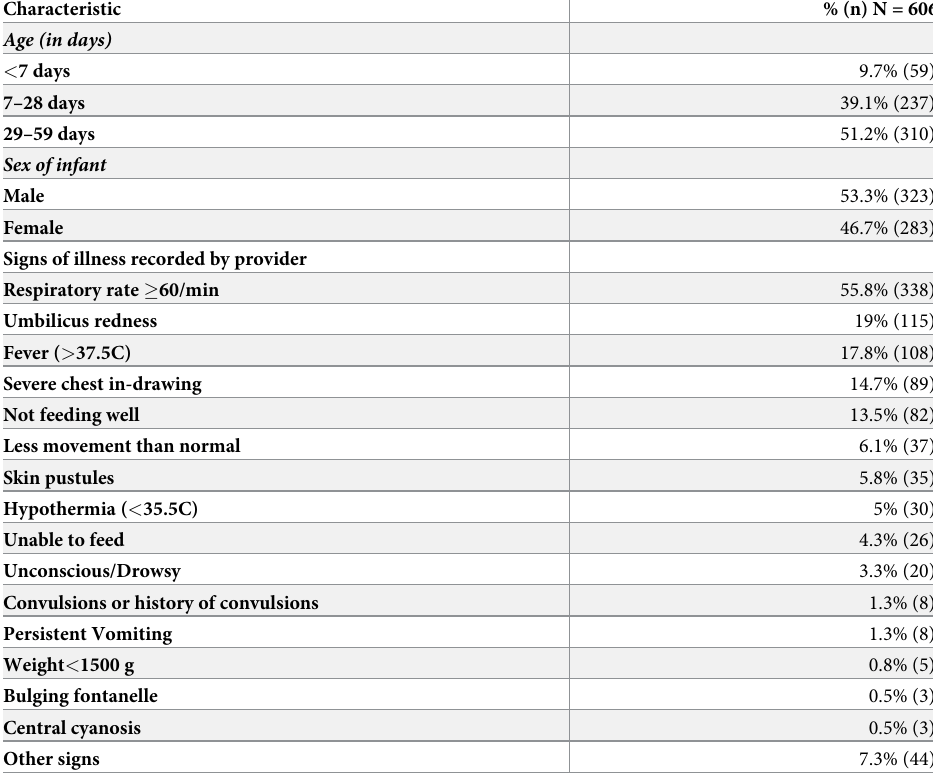
Table 4. Descriptive characteristics of sick young infants assessed at health centers.